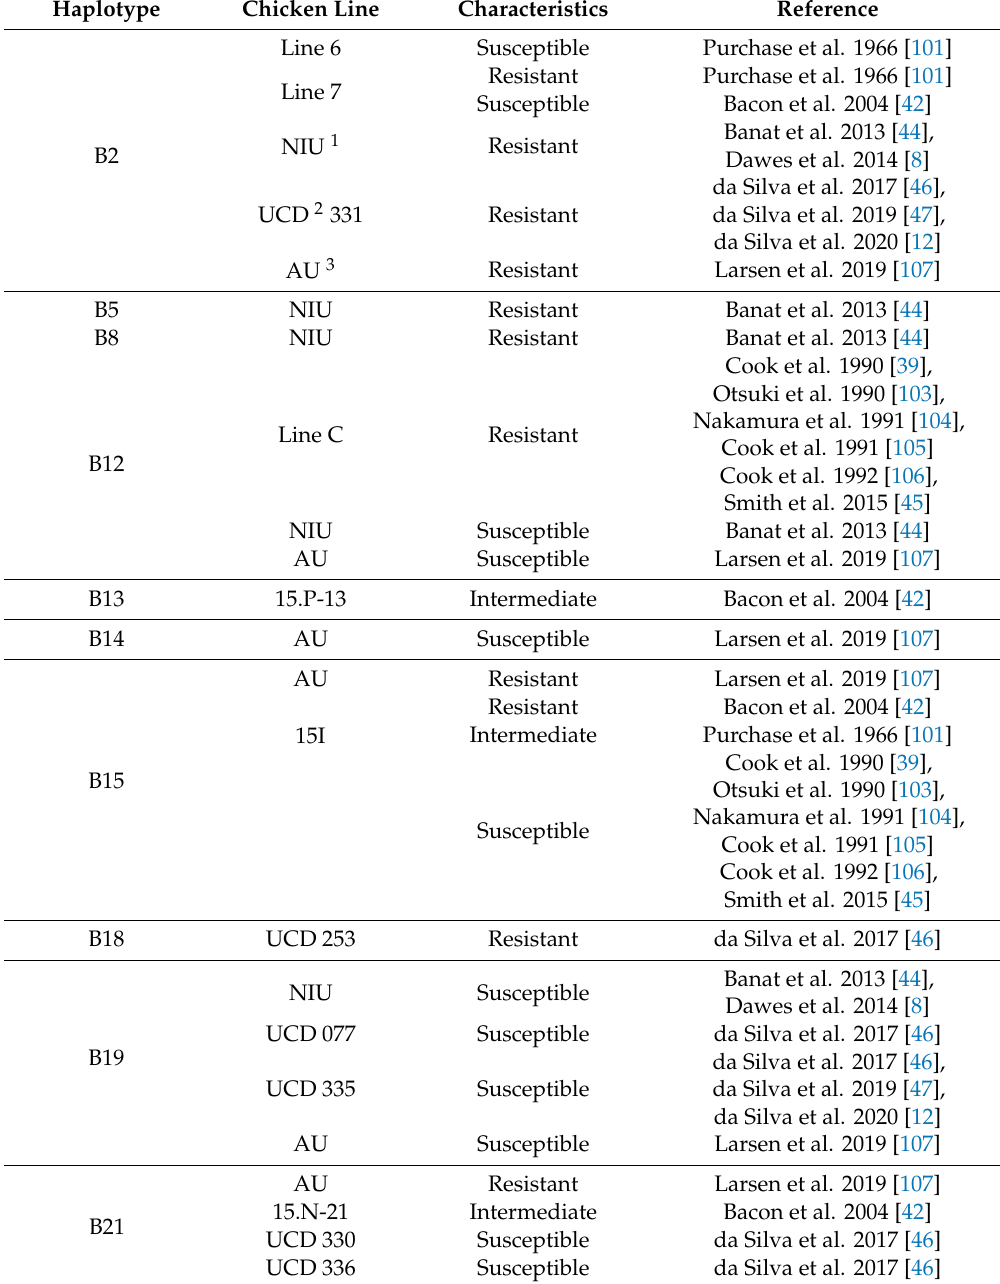
e ff ect of the B haplotype at di ff erent levels on disease outcome. Nevertheless, these results show that non-MHC genes linked to innate immunity and inflammation play a relevant role in disease resistance. Table 1. Major histocompatibility complex B haplotypes and their association with genetic resistance to infectious bronchitis